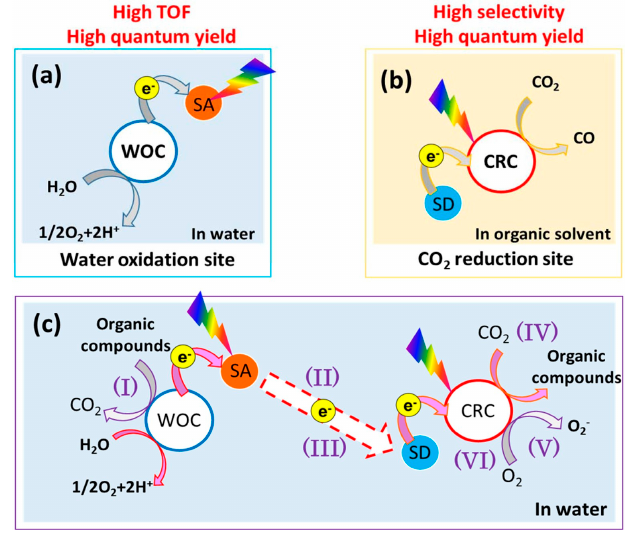
Figure 3. Advantages and disadvantages of metal complex catalysts for CO 2 reduction with H 2 O oxidation (adapted from [8]). ( a ) The advantages of H 2 O oxidation of a metal complex catalyst (H 2 O oxidation site) with a sacrificial electron acceptor (SA); ( b ) the advantages of CO 2 reduction for a metal complex catalyst (CO 2 reduction site) with a sacrificial electron donor (SD); ( c ) the problems encountered when combining H 2 O oxidation site and CO 2 reduction site.